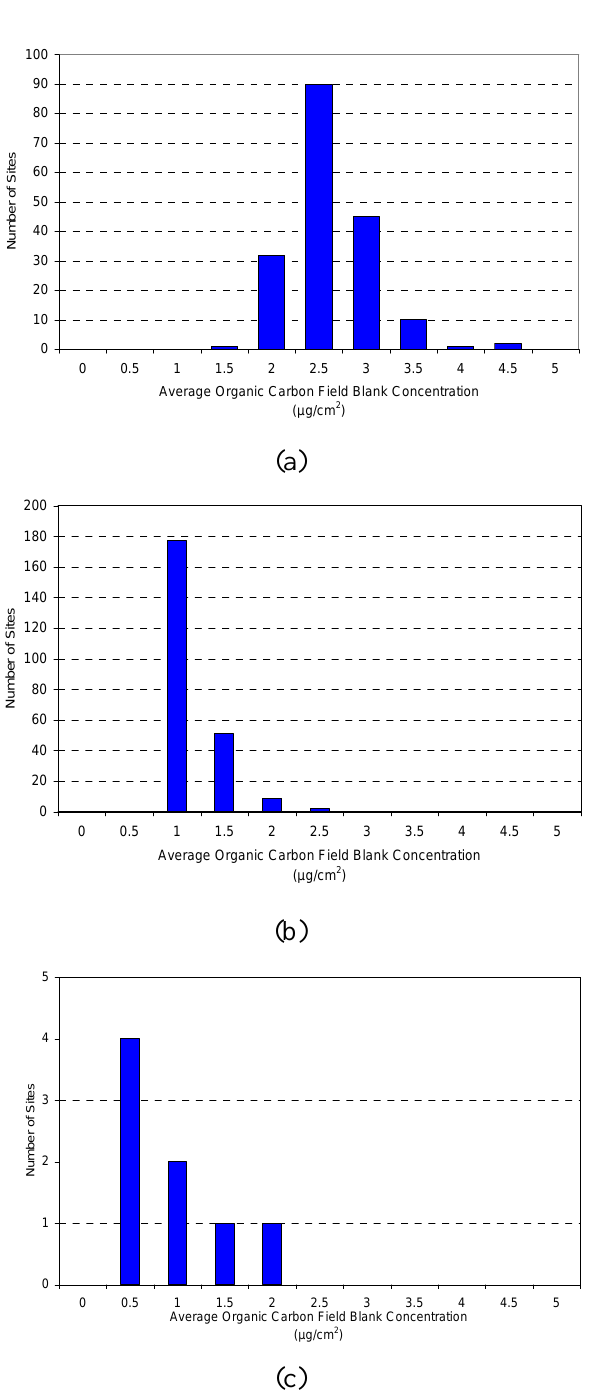
Fig. 2. Field blank organic carbon (OC bQF ) concentration density (µg/cm 2 ) for: (a) 181 IMPROVE sites, (b) 239 STN/CSN sites, and (c) eight SEARCH sites for the period from 1 January 2005 to 31 December 2006 (each bar represents the concentration sector less than or equal to the assigned